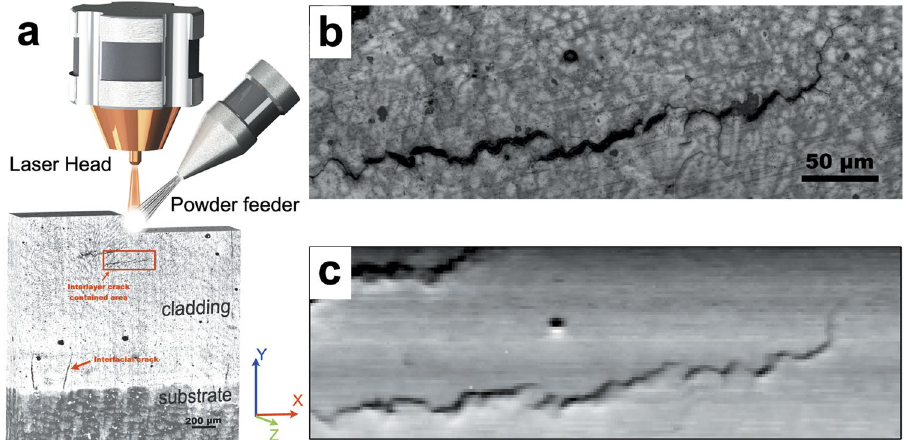
Figure 1. Schematic of 3D printing specimen preparation and microstructure characterization. ( a ) Laser 3D printing setup and a low magnification optical micrograph showing two types of cracks parallel and perpendicular to the substrate/cladding interface. ( b ) Optical microscope image of the investigated crack containing region. ( c ) Raw intensity map generated from μ XRD to show the cracks as low intensity pixels with reasonable contrast and spatial